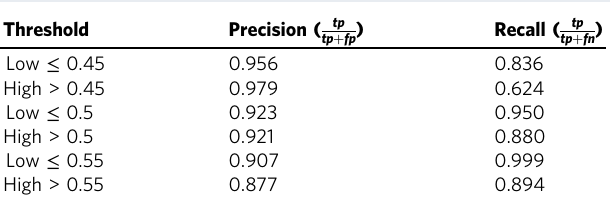
Fig. 5 Free-energy surface for tri-alanine. The absolute minimum in the plot corresponds to the poly-proline-like conformation, which is not the preferred conformation in the case of deca-alanine, represented in the upper left corner. Table 1 Classi fi cation results for deca-alanine with different